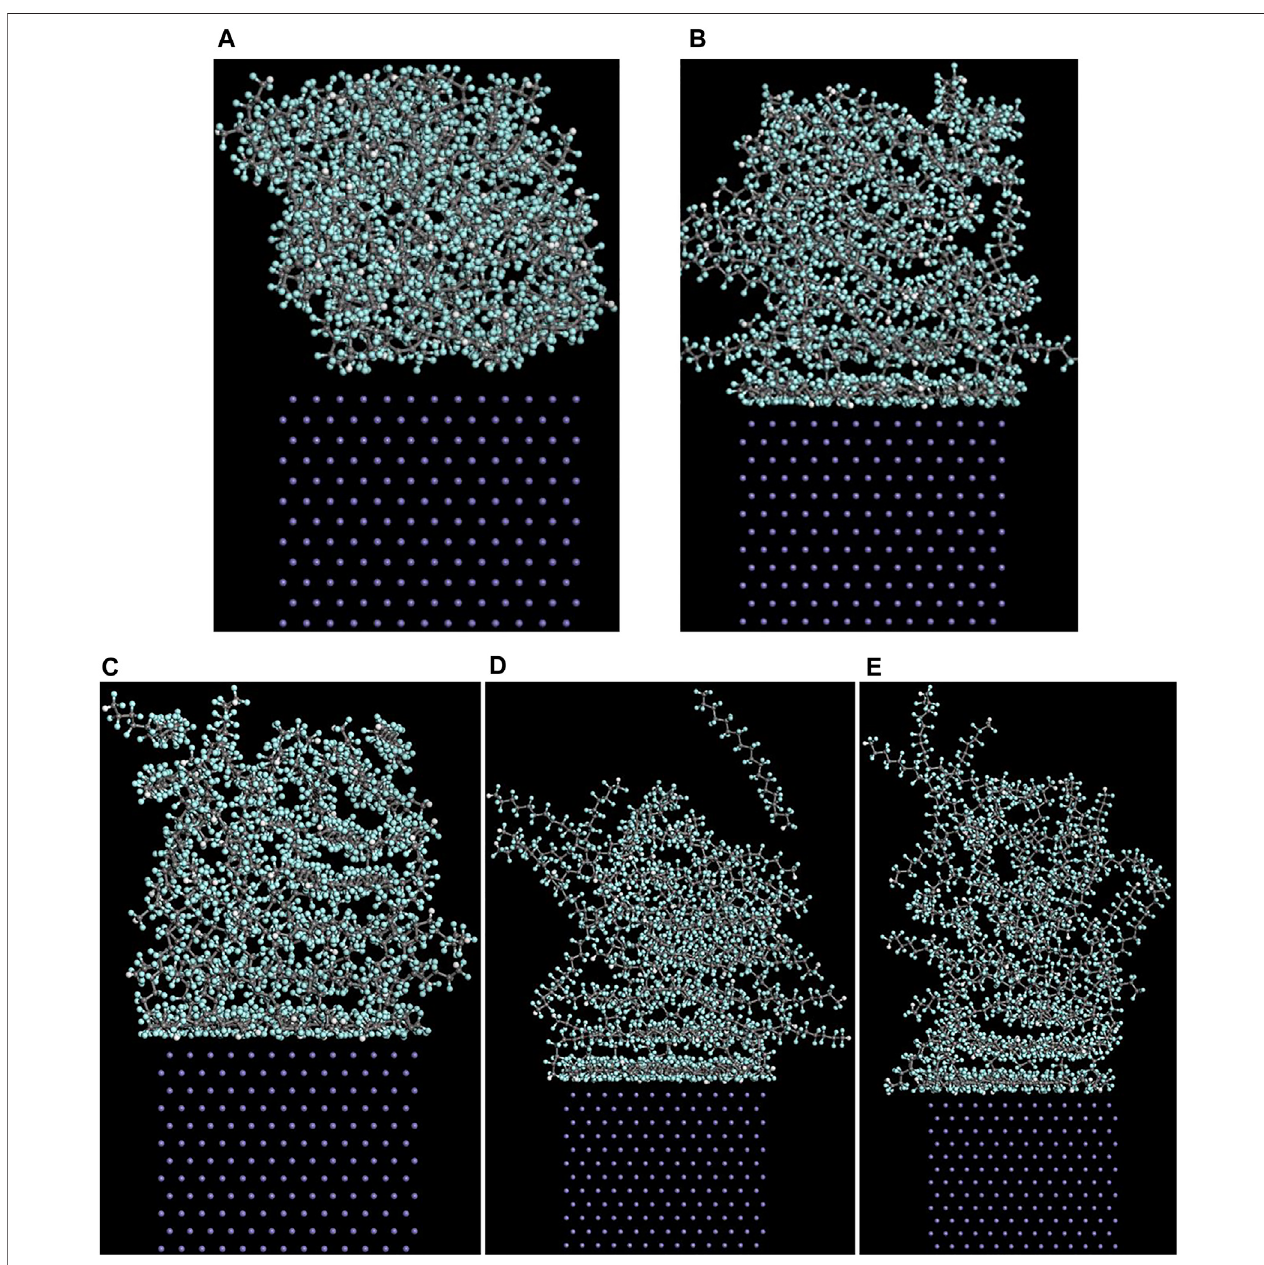
FIGURE 10 | Side views of the (110)/PTFE interface models (A) before and after the molecular dynamics of different temperatures: (B) 25 ° C (C) 100 ° C, (D) 200 ° C, and (E) 300 °